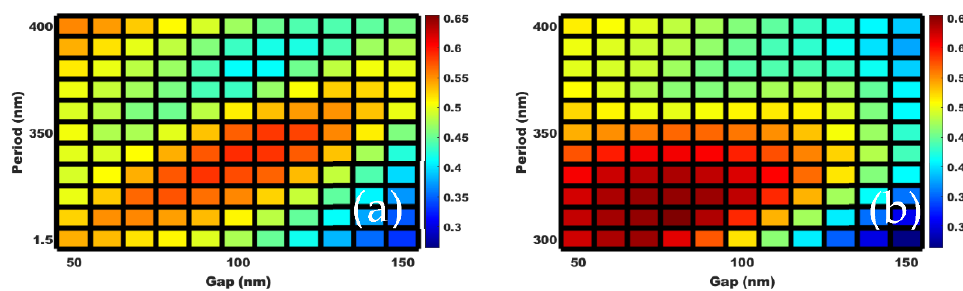
Figure 8. The calculated FoM_Total on UV blocking due to the color layer above a solar cell for a varying period and gap of the TiO 2 resonator array, when ( a ) the resonator array is placed on a silica substrate and ( b ) the resonator array is embedded inside a silica medium.